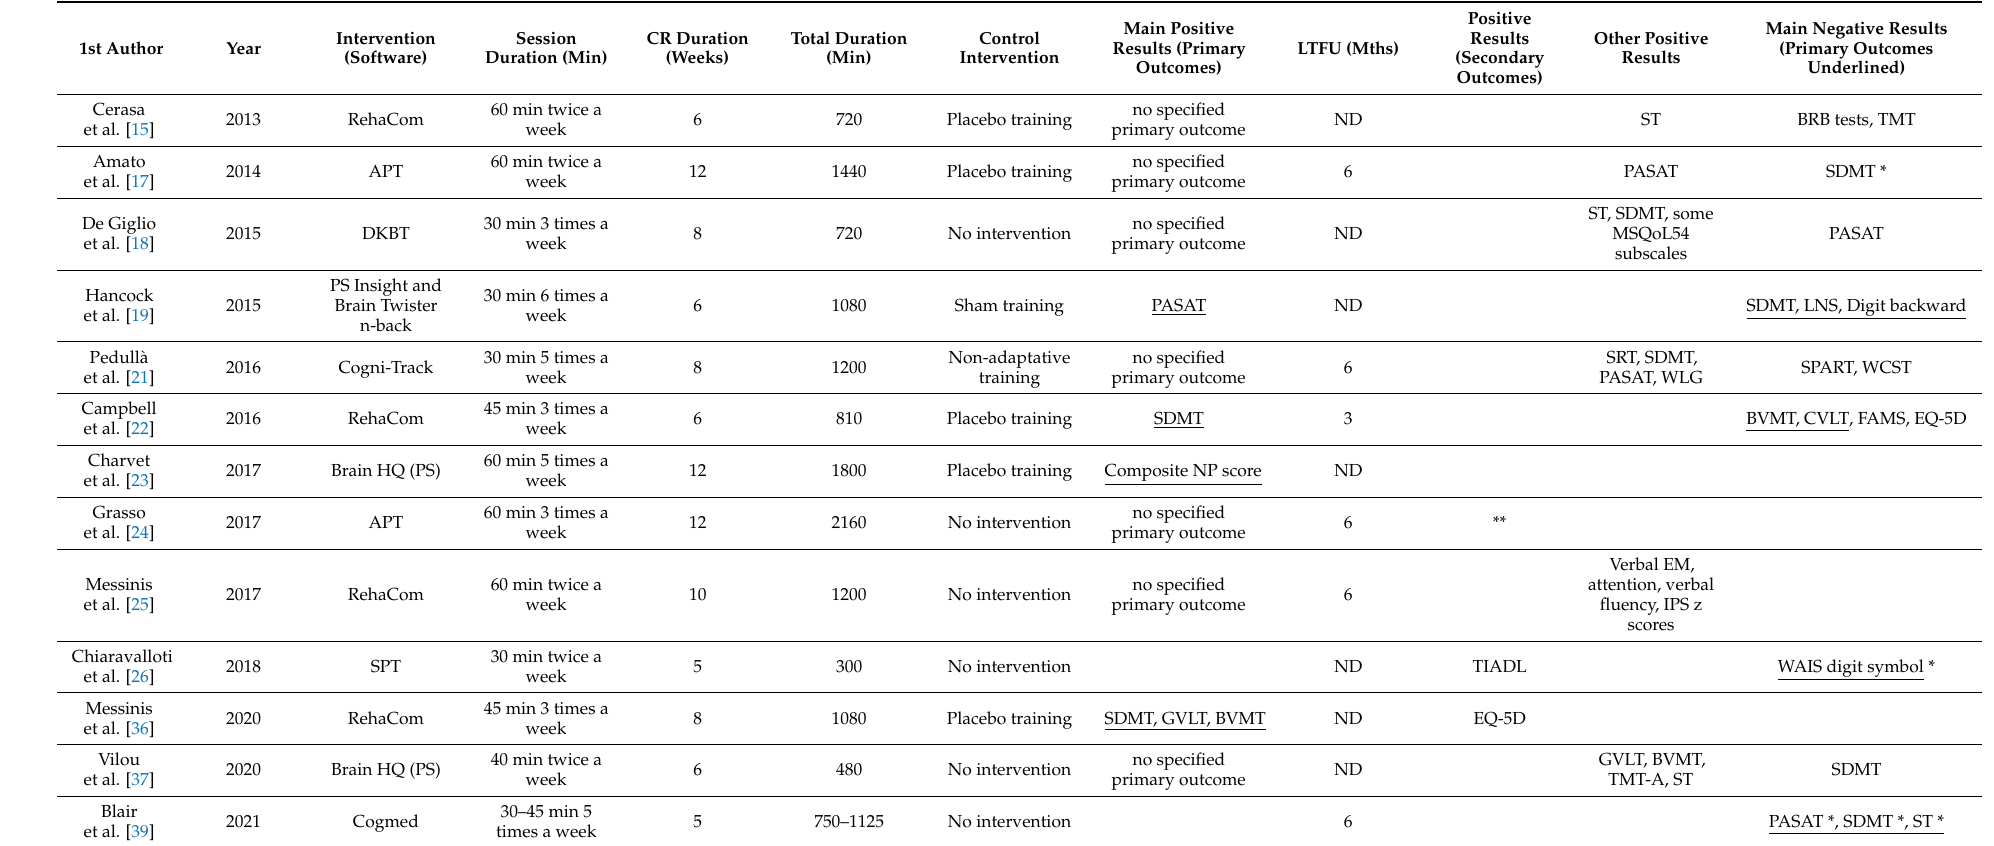
Table 5. Blinded RCT of CT in